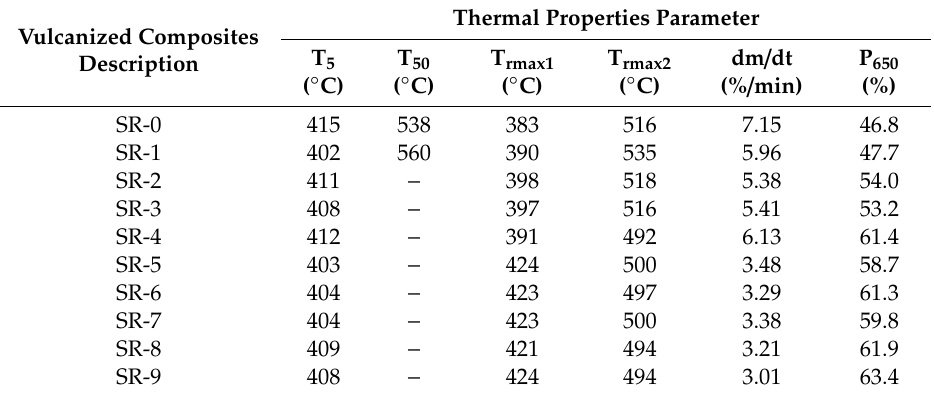
Table 4. Thermal properties of SR rubber composites.